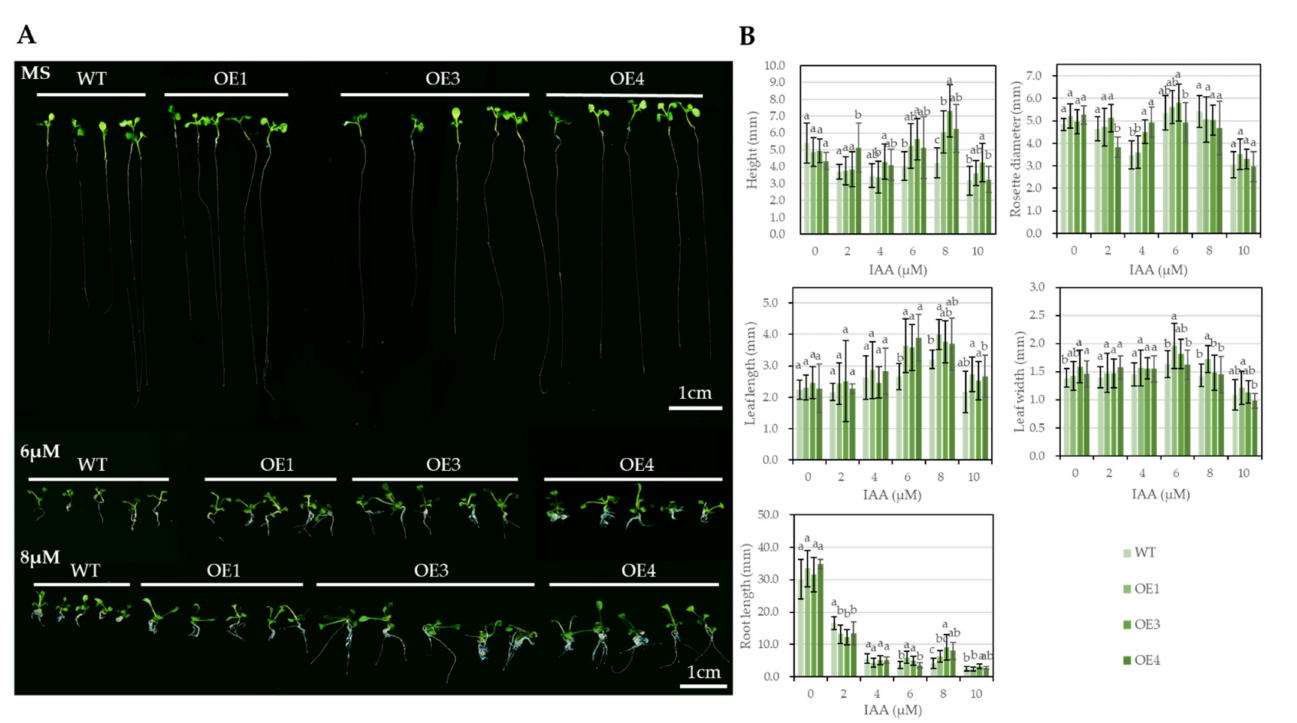
Figure 3. Phenotypic images and measurements of wild-type (WT) and SgGH3.1 overexpressing (OE1, 3 and 4) A. thaliana seedlings grown in MS medium supplemented with different concentrations of IAA. ( A ) Scans of WT and SgGH3.1 -OE A. thaliana seedlings grown in MS medium supplemented with 0, 6 and 8 µ M IAA. ( B ) Height, rosette diameter, leaf length and width, and root length of WT and SgGH3.1 -OE A. thaliana seedlings grown in MS medium supplemented with 0, 2, 4, 6, 8 and 10 µ M IAA. Different letters above the columns indicate significant differences at p < 0.01 between different IAA